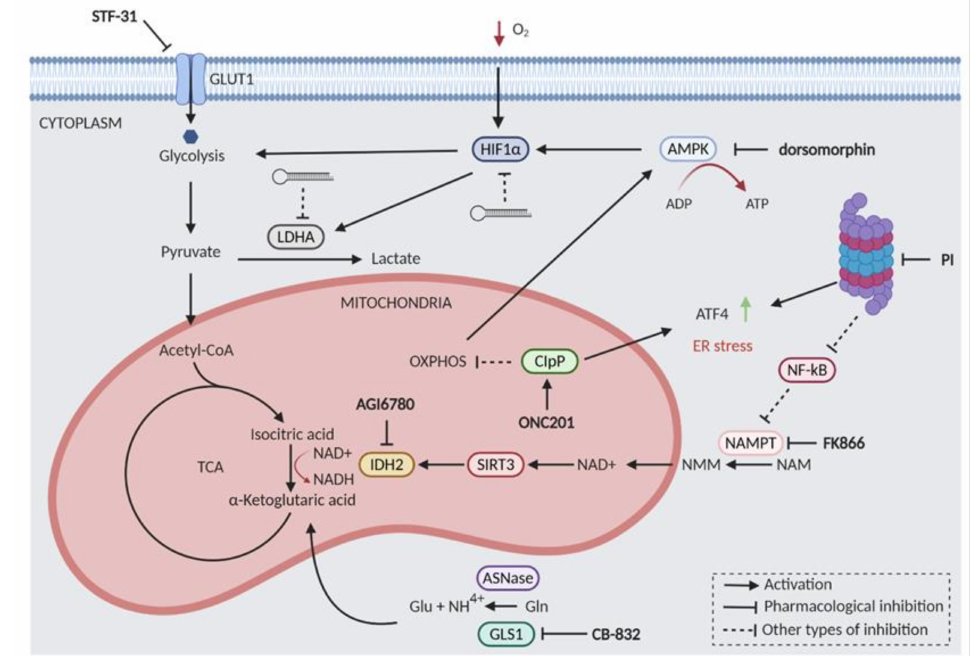
Figure 4. Proteasome inhibitors and metabolic pathways. Enhancement of glucose and glutamine metabolism is a hallmark of cancer cells, including multiple myeloma (MM). Targeting deranged cellular metabolism at various levels enhances the cytotoxicity of proteasome inhibitors in MM. Inhibition of the glucose transporter GLUT1 (STF-31) or the non-pharmacological inhibition of HIF1 α and LDHA enzymes result in synergistic cell death with proteasome inhibitors (PI). The tricarboxylic acid (TCA) cycle enzyme IDH2 is synthetic lethal to PI through NAMPT/SIRT3/IDH2 pathway (AGI- 6780, FK866). Degradation of glutamine can be targeted with Asparaginase (ASNase) or Glutaminase inhibitor (CB-832), affecting glutamate-dependent metabolites of TCA cycle. The cellular energy sensor AMPK is synthetically lethal to PI. OXPHOS inhibition by the mitochondrial protease ClpP (ONC201) leads to cellular stress and upregulation of transcriptional factor